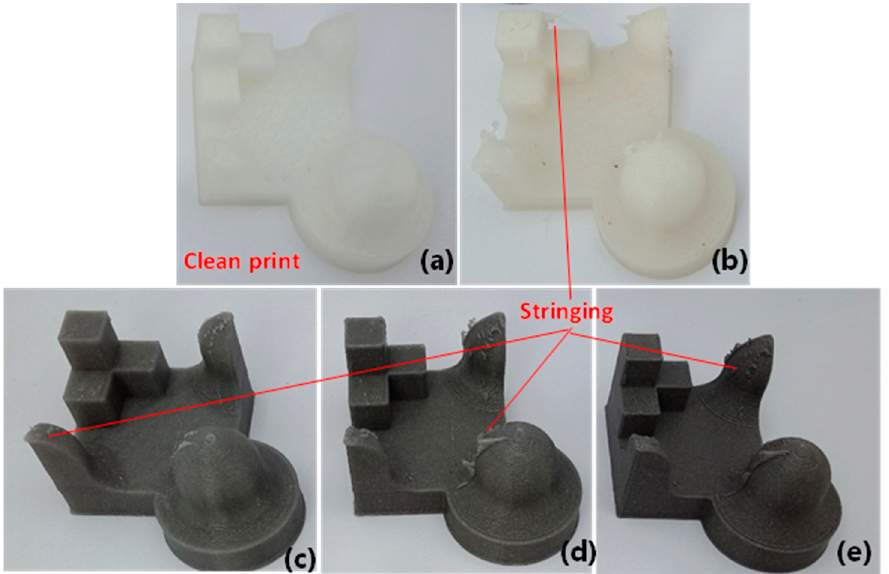
Figure 8. Benchmark print models for: ( a ) OTS; ( b ) waste; ( c ) 2% Mg; ( d ) 4% Mg; ( d ) 8% Mg.